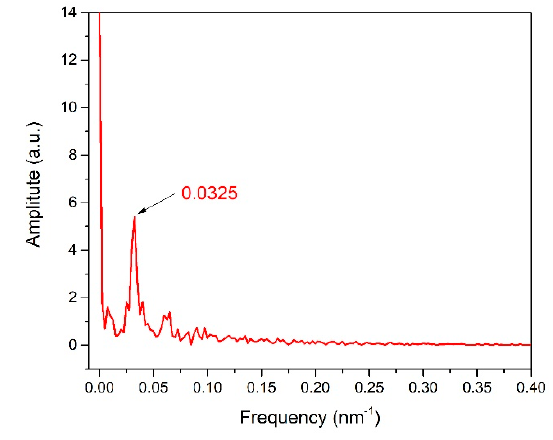
Figure 3. The fast Fourier transform (FFT) spectrum of unetched MOF.